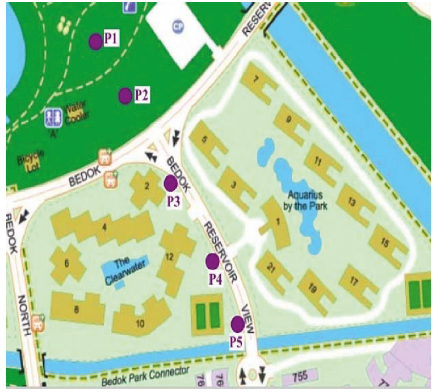
Figure 1: Study area and field measurement points at